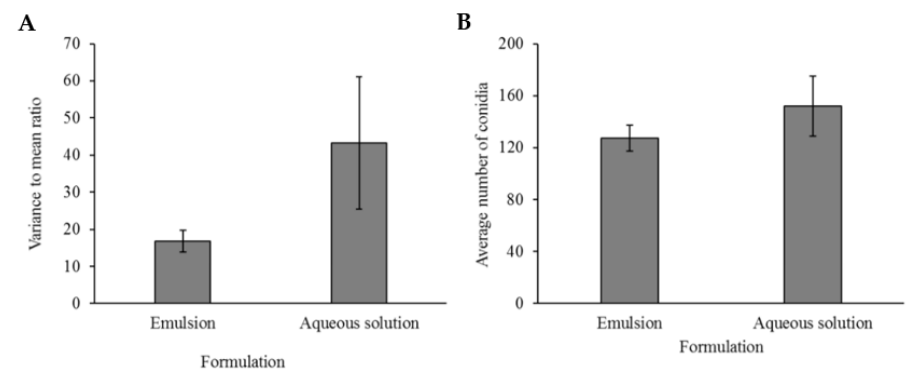
Figure 4. ( A ) Variance to mean ratio ± SE by treatment. If 0 < variance-to-mean ratio (VMR) < 1 distribution is regularly spaced, if VMR = 1 distribution is random, if 1 < VMR dis- tribution is clustered. A Welch analysis of variance (ANOVA) was employed, and no significant difference was found between the distribution pattern of the conidia in the various formulations, yet a significant difference was found in the variance (Bartlett’s test: F = 19.5792, p -value < 0.0001). ( B ) Mean numbers of conidia ± SE counted in the various microscopic fields used to calculate VMR. A Welch ANOVA was employed, and no significant difference was found between treatments, yet a significant difference was found in variance (Bartlett’s test: F = 13.9549, p -value = 0.0002).